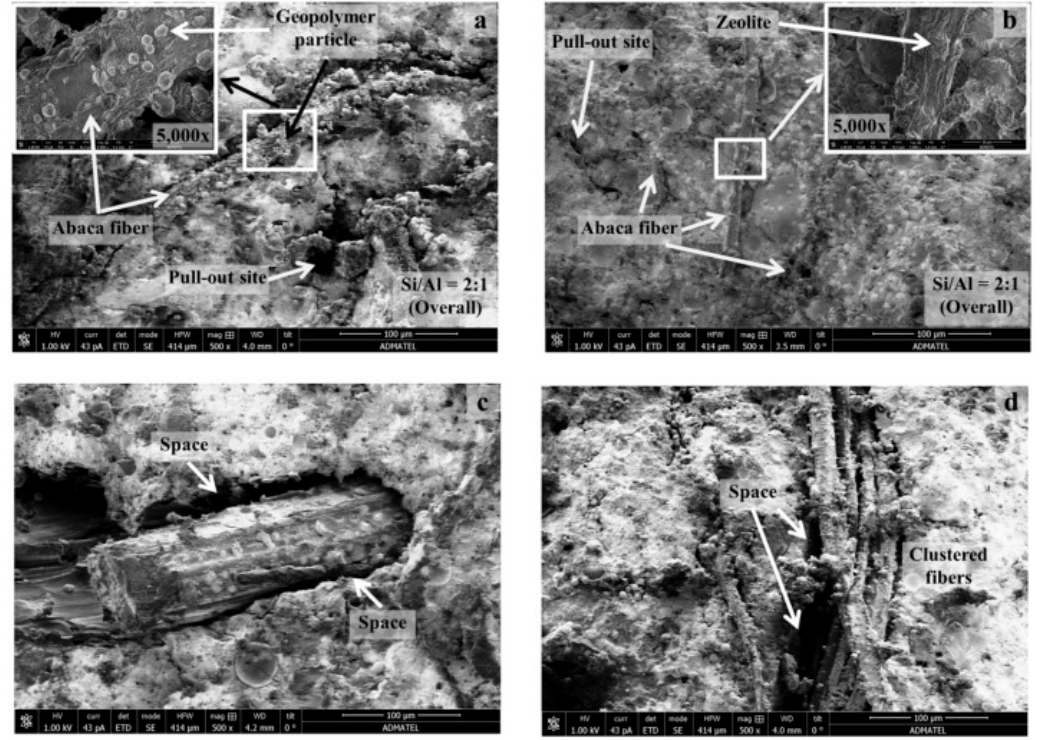
Figure 5. SEM images of geopolymer composite fracture surfaces reinforced with unmodified and Al 2 (SO 4 ) 3 -modified abaca fibers. ( a ) Geopolymer particles observed on unmodified abaca fiber and ( c ) visible gaps at the interface between unmodified abaca fiber and the geopolymer matrix. ( b ) Geopolymer reinforced with Al 2 (SO 4 ) 3 -modified abaca and ( d ) narrowed gaps detected at the interface between modified abaca fiber and geopolymer matrix. Open access under terms and conditions of the Creative Commons Attribution (CC BY), reference [15].